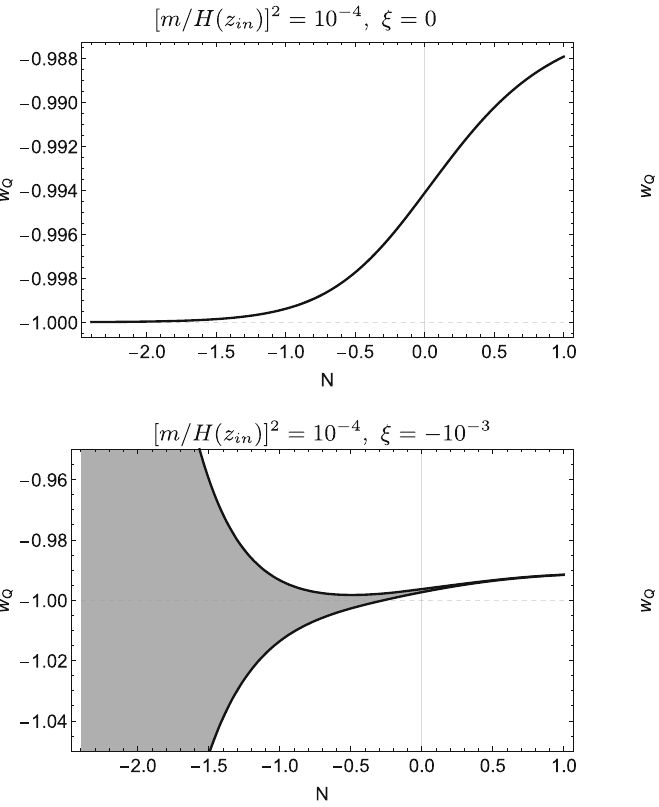
tum backreaction that scales (to a good approximation) as dark matter. Note that the uncertainty is larger at larger redshift. However, that does not reduces in any significant way testability of the model, because at large redshifts the relative contribution of dark energy is